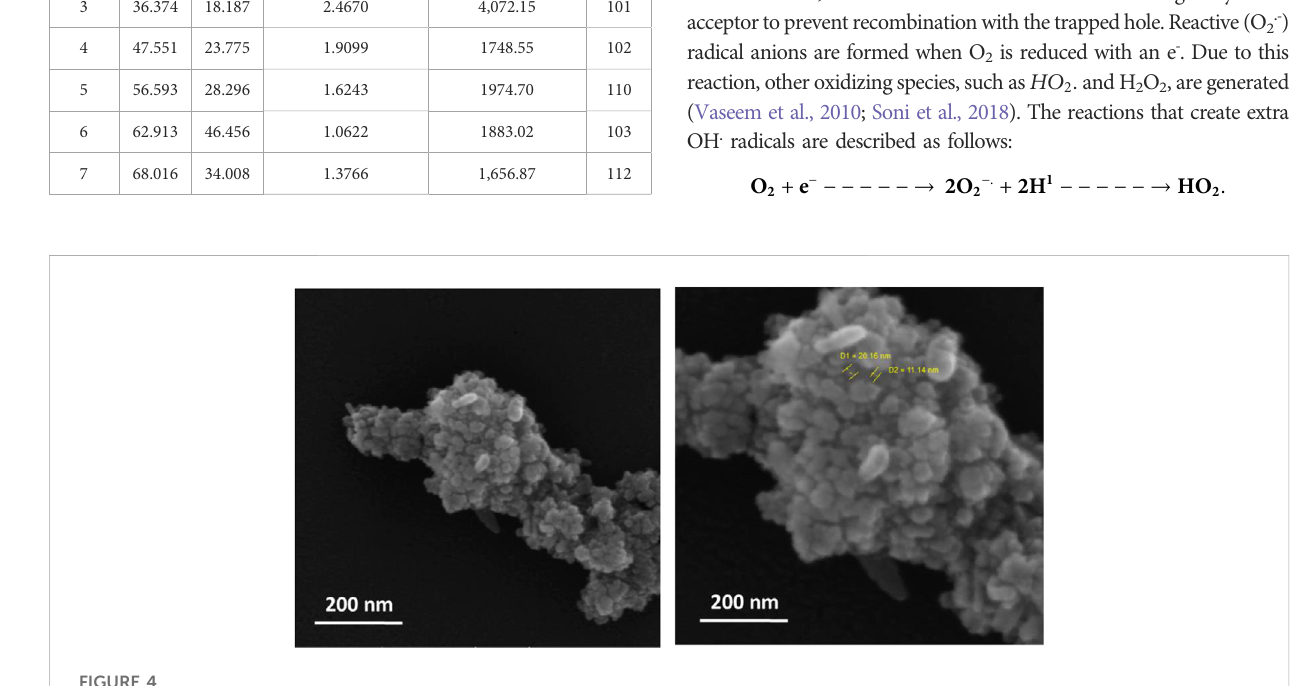
FIGURE 4 FESEM images of ZnO